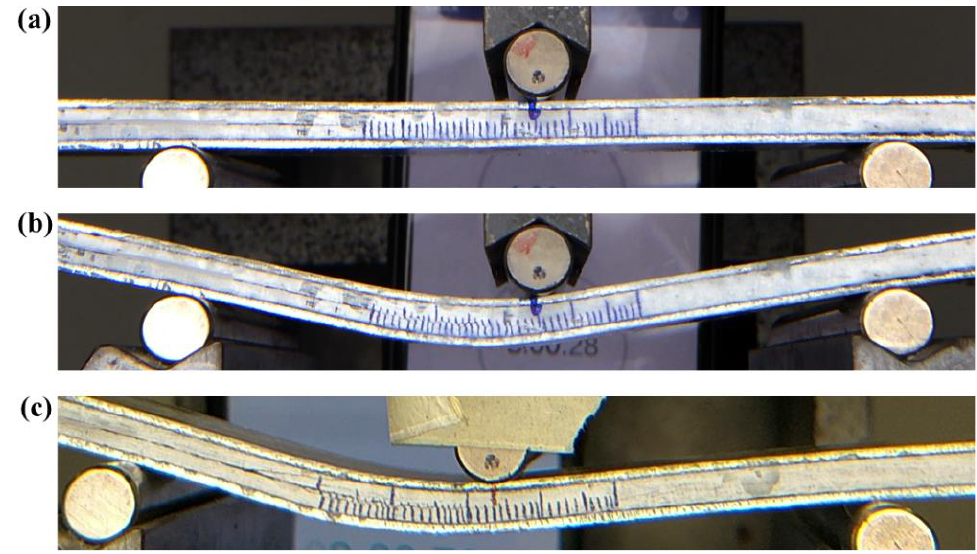
Figure 18. Macro-photographs of ( a ) Carbon_UHMWPE/Elium ® composite at the start of the test (t = 0 s) ( b ) Carbon_UHMWPE/Elium ® composite between testing (t = 480 s) ( c ) Car- bon_UHMWPE/Epoxy composite between testing (t = 480 s).